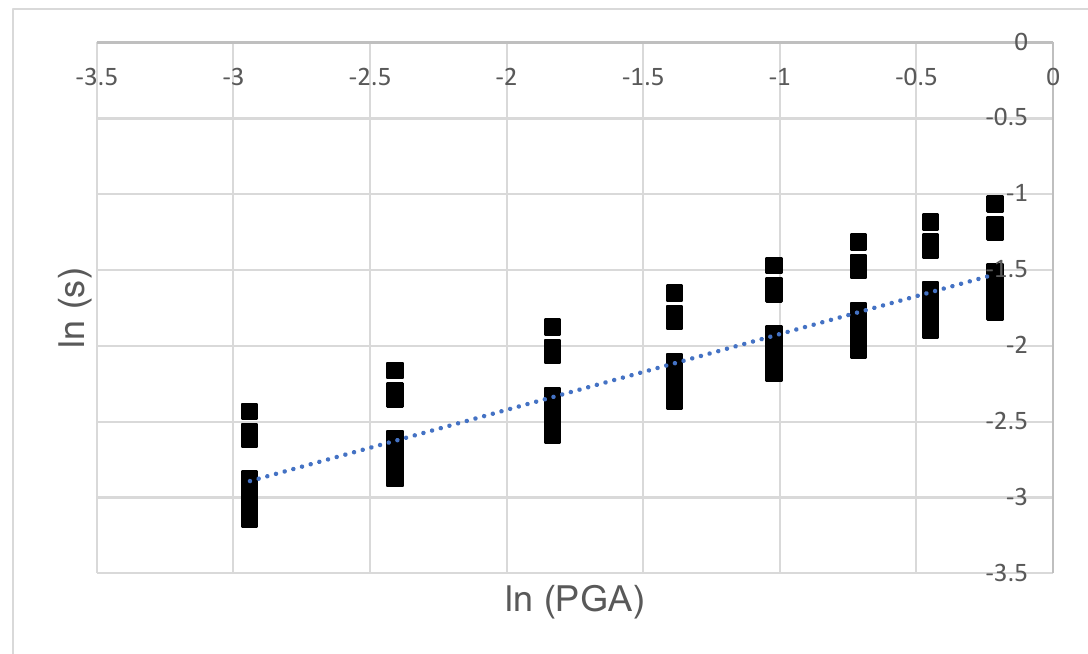
Figure 9. Settlement Vs soil depth (input motion: RRS).